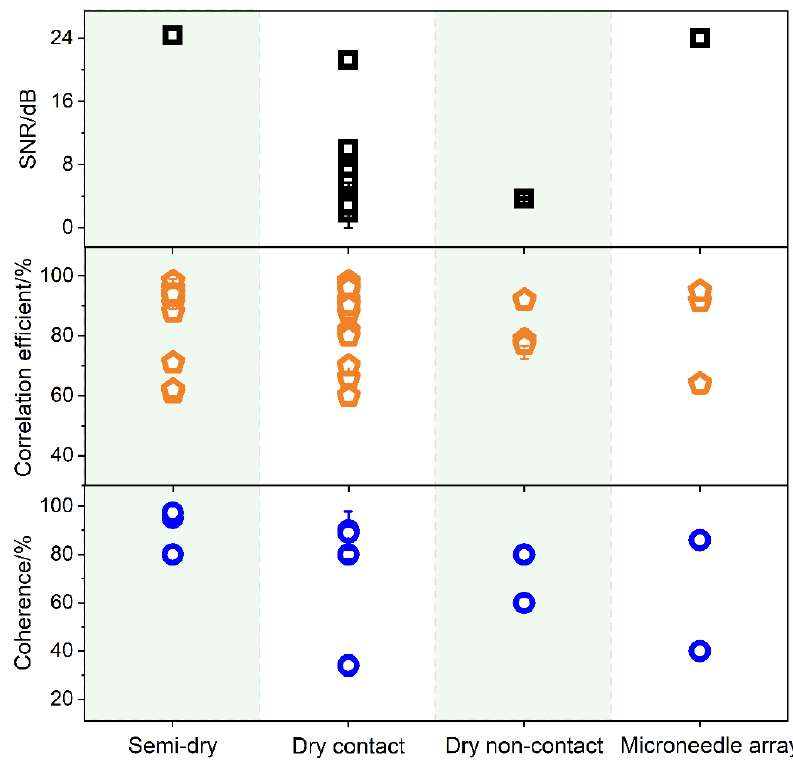
Figure 4. The SNR (black square), signal correlation (yellow diamond), and coherence (blue dots) of semi-dry electrodes (Data derived from [23,27,45,59,63–66]), dry contact electrodes (Data derived from [39,44,46,53,55,70,72,73,75,76,81,83,85,86,88,89,91,92,94,96,98,116–121]), dry non- contact electrodes (Data derived from [11,47,48]) and microneedle array electrodes (Data derived from [57,58,102]), details are in Appendix A Tables